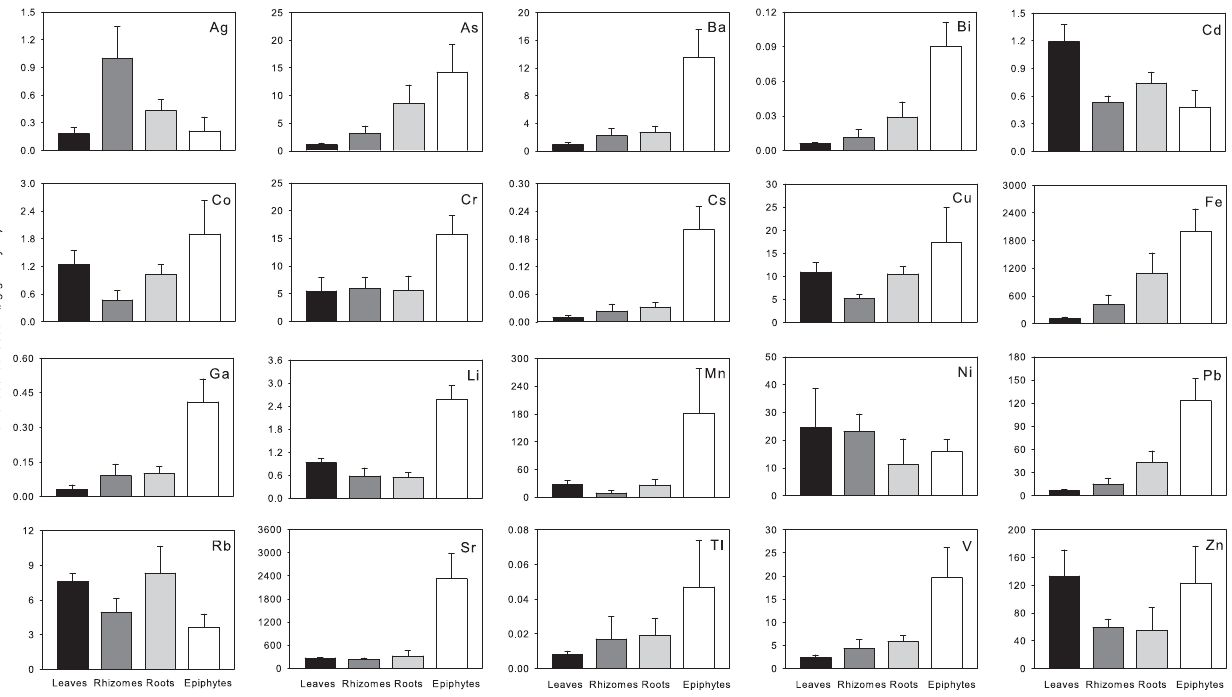
Fig. 1. Annual trace element concentration (µgg − 1 dry wt; mean ± SD) in the compartments of Posidonia oceanica (leaves, rhizomes, roots and epiphytes). The letters on the right top of each graph indicate the trace